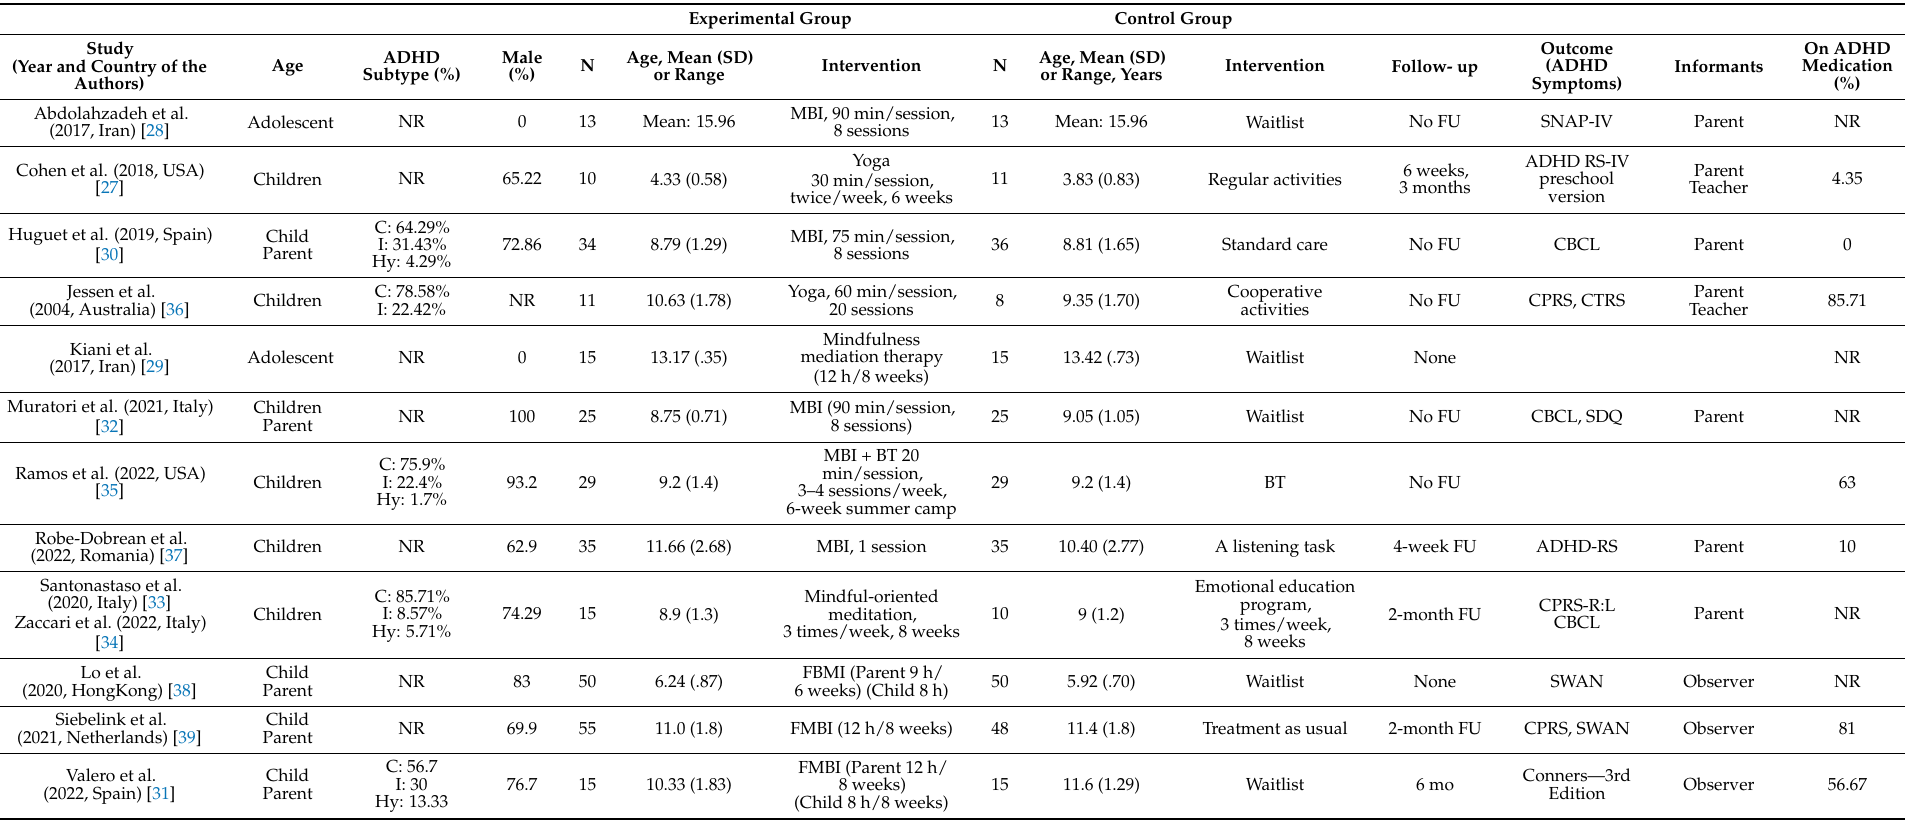
Table 1. Characteristics of studies included in the